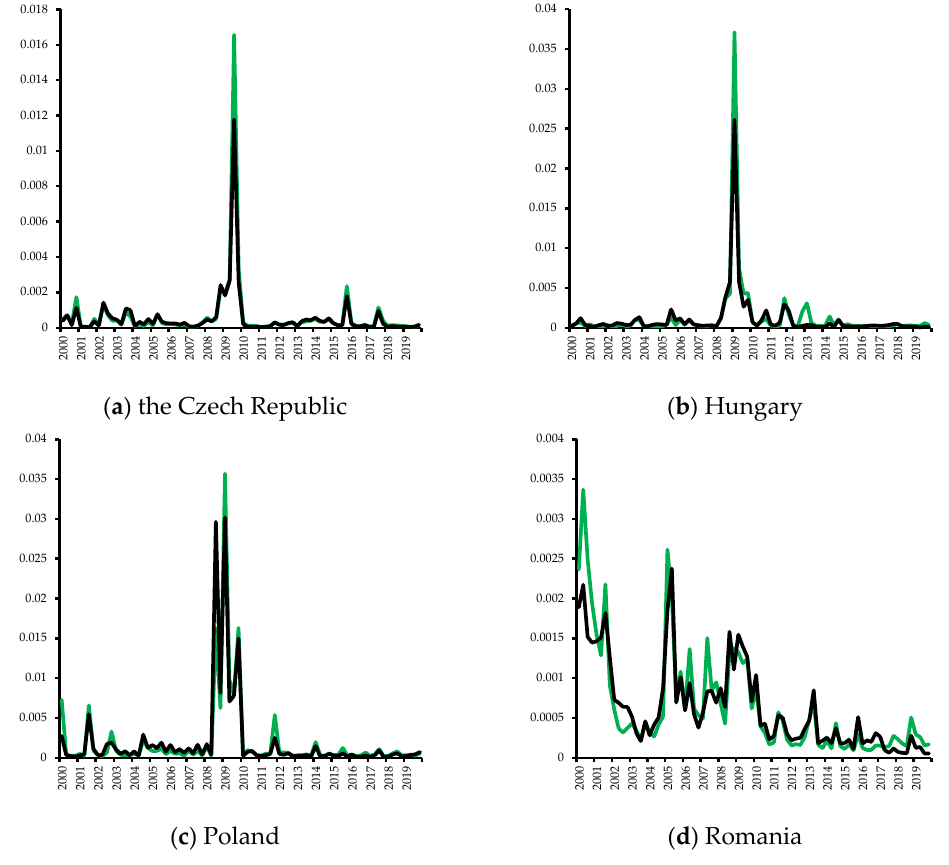
Figure 2. Conditional variance from EGARCH(1,1) Model.